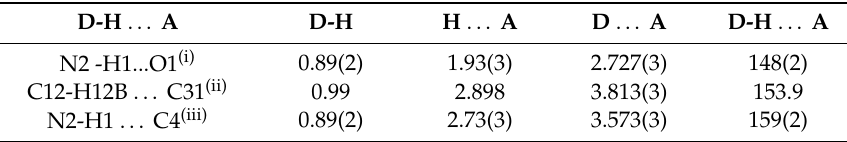
Table 2. The hydrogen bond distances (Å) and angles ( ◦ ) in